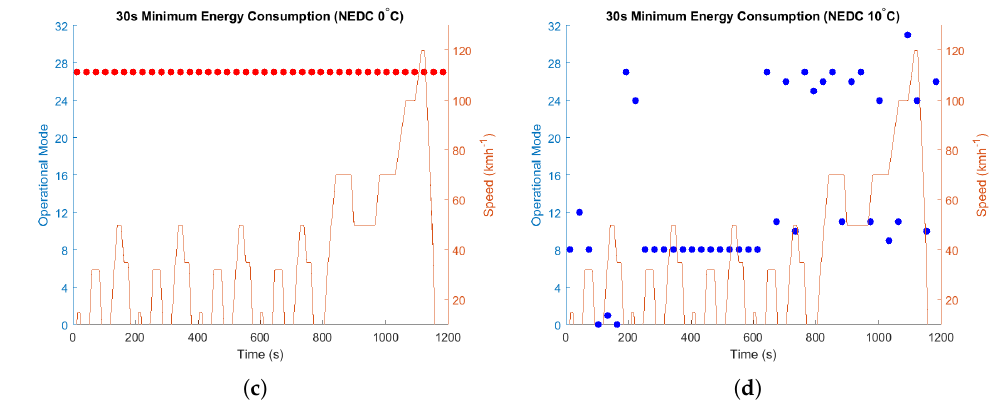
Figure 8. The best operational mode during 30 s intervals as a function of time is shown through the Warm up drive cycle over temperatures − 20 ◦ C ( a ), − 10 ◦ C ( b ), 0 ◦ C ( c ) and 10 ◦ C ( d ). Blue dots show the operational mode which used the least energy during that 30 s interval. This has been overlaid with the NEDC drive cycle. Red dots indicate when no operational mode met cabin target temperature, blue dots indicate multiple operational modes met cabin target temperature.